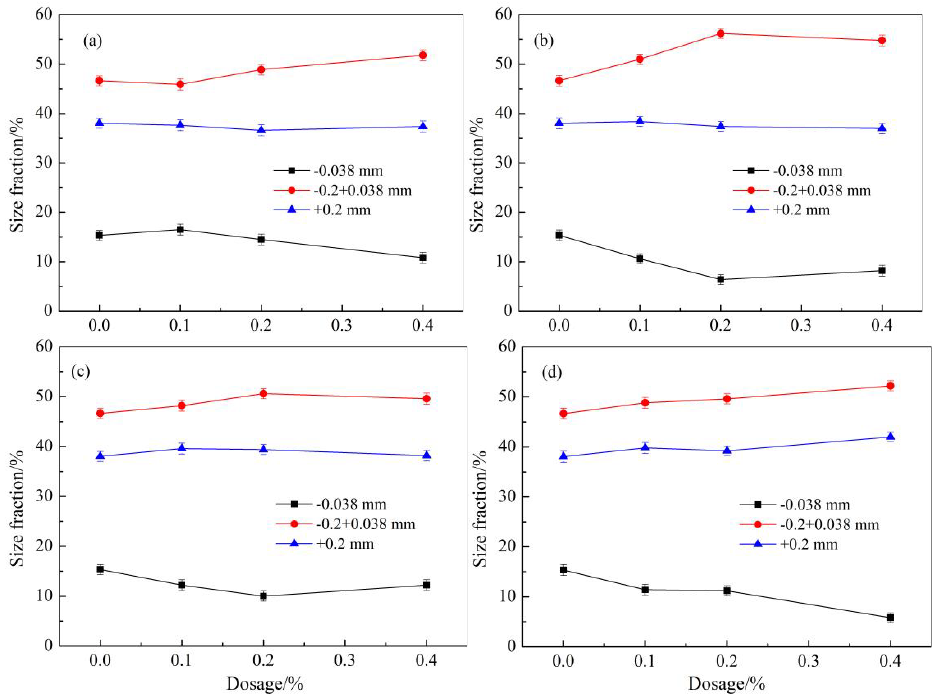
Figure 2. The effects of polyacrylamide molecular weight on the grinding product size with ( a ) PAM300, ( b ) PAM500, ( c ) PAM800 and ( d ) PAM1200.